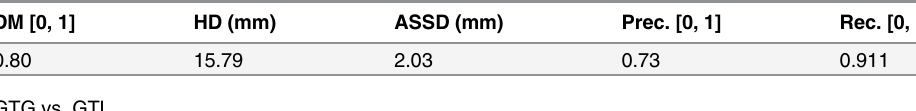
Table 4. Inter-observer